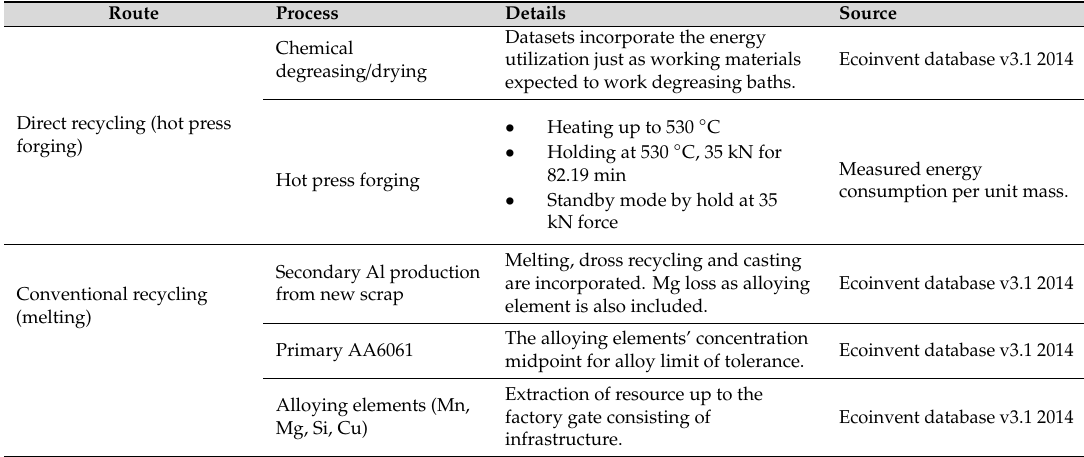
Table 4. Main life cycle inventory data and sources for each process